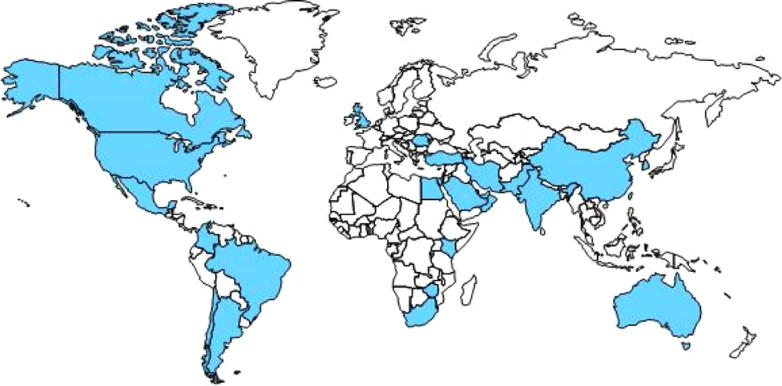
Countries Represented on the Expert Panel potentially provide more affordable treatments than corneal grafts and could address current shortages of donor material.